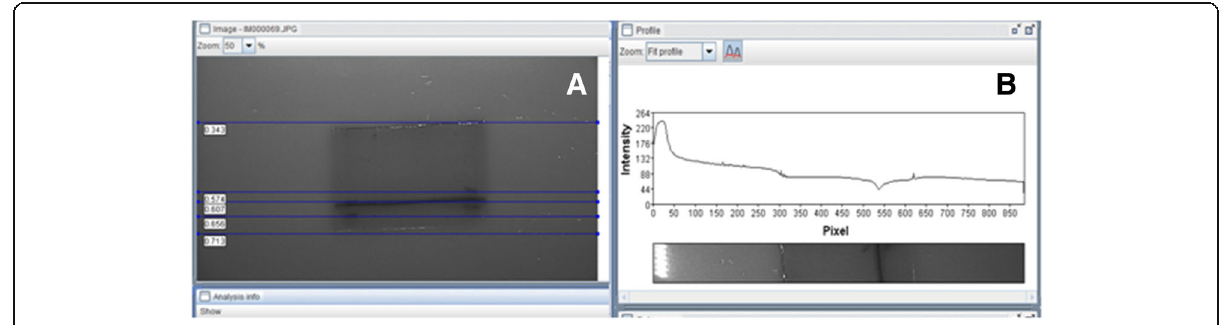
Fig. 3 Densitometry analysis of purified protein samples. a Rf value of protein sample. b Purified protein sample band